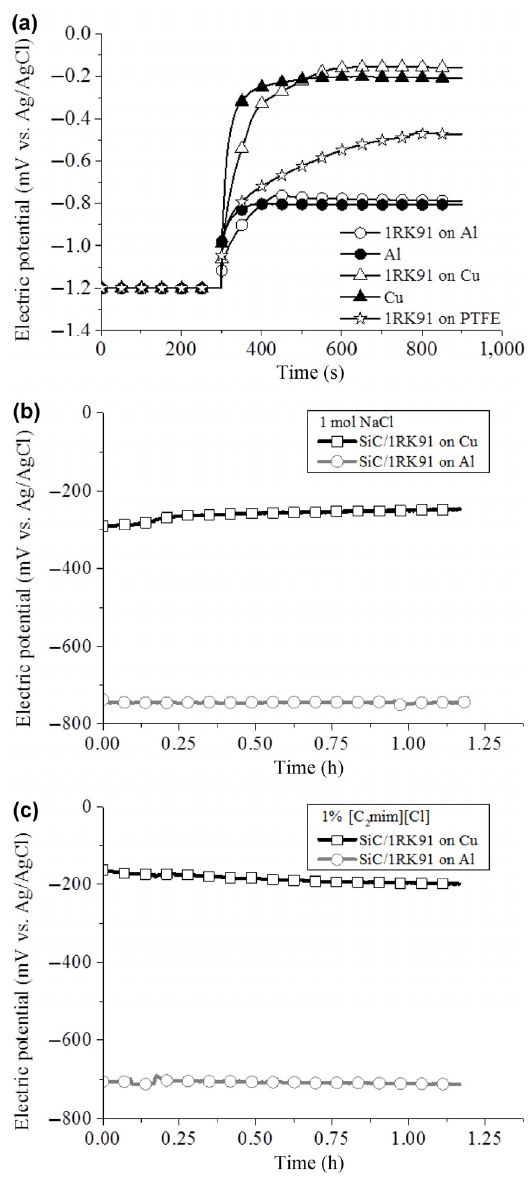
Fig. 2 Electrochemical investigations: (a) Self-corrosion potentials of Al and Cu (filled symbols) and open circuit potential using different material combinations in 1 mol NaCl solution were steel 1RK91 was set as working electrode (unfilled symbols). Induced galvanic potential during tribological test using 1 molar NaCl (b) and 1% [C 2 mim][Cl] (c) aqueous solution during tribological test (copper and aluminum contacted as working